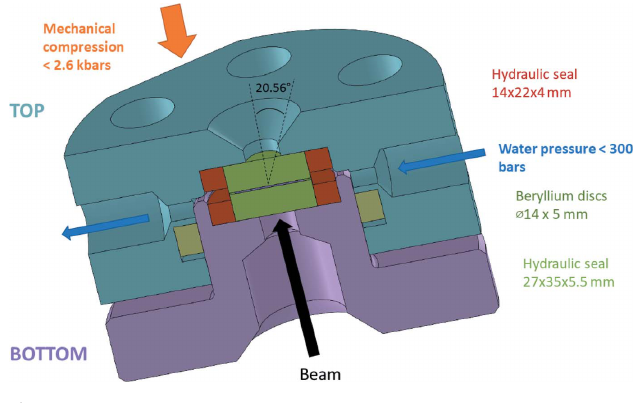
Figure 1 Sketch of the